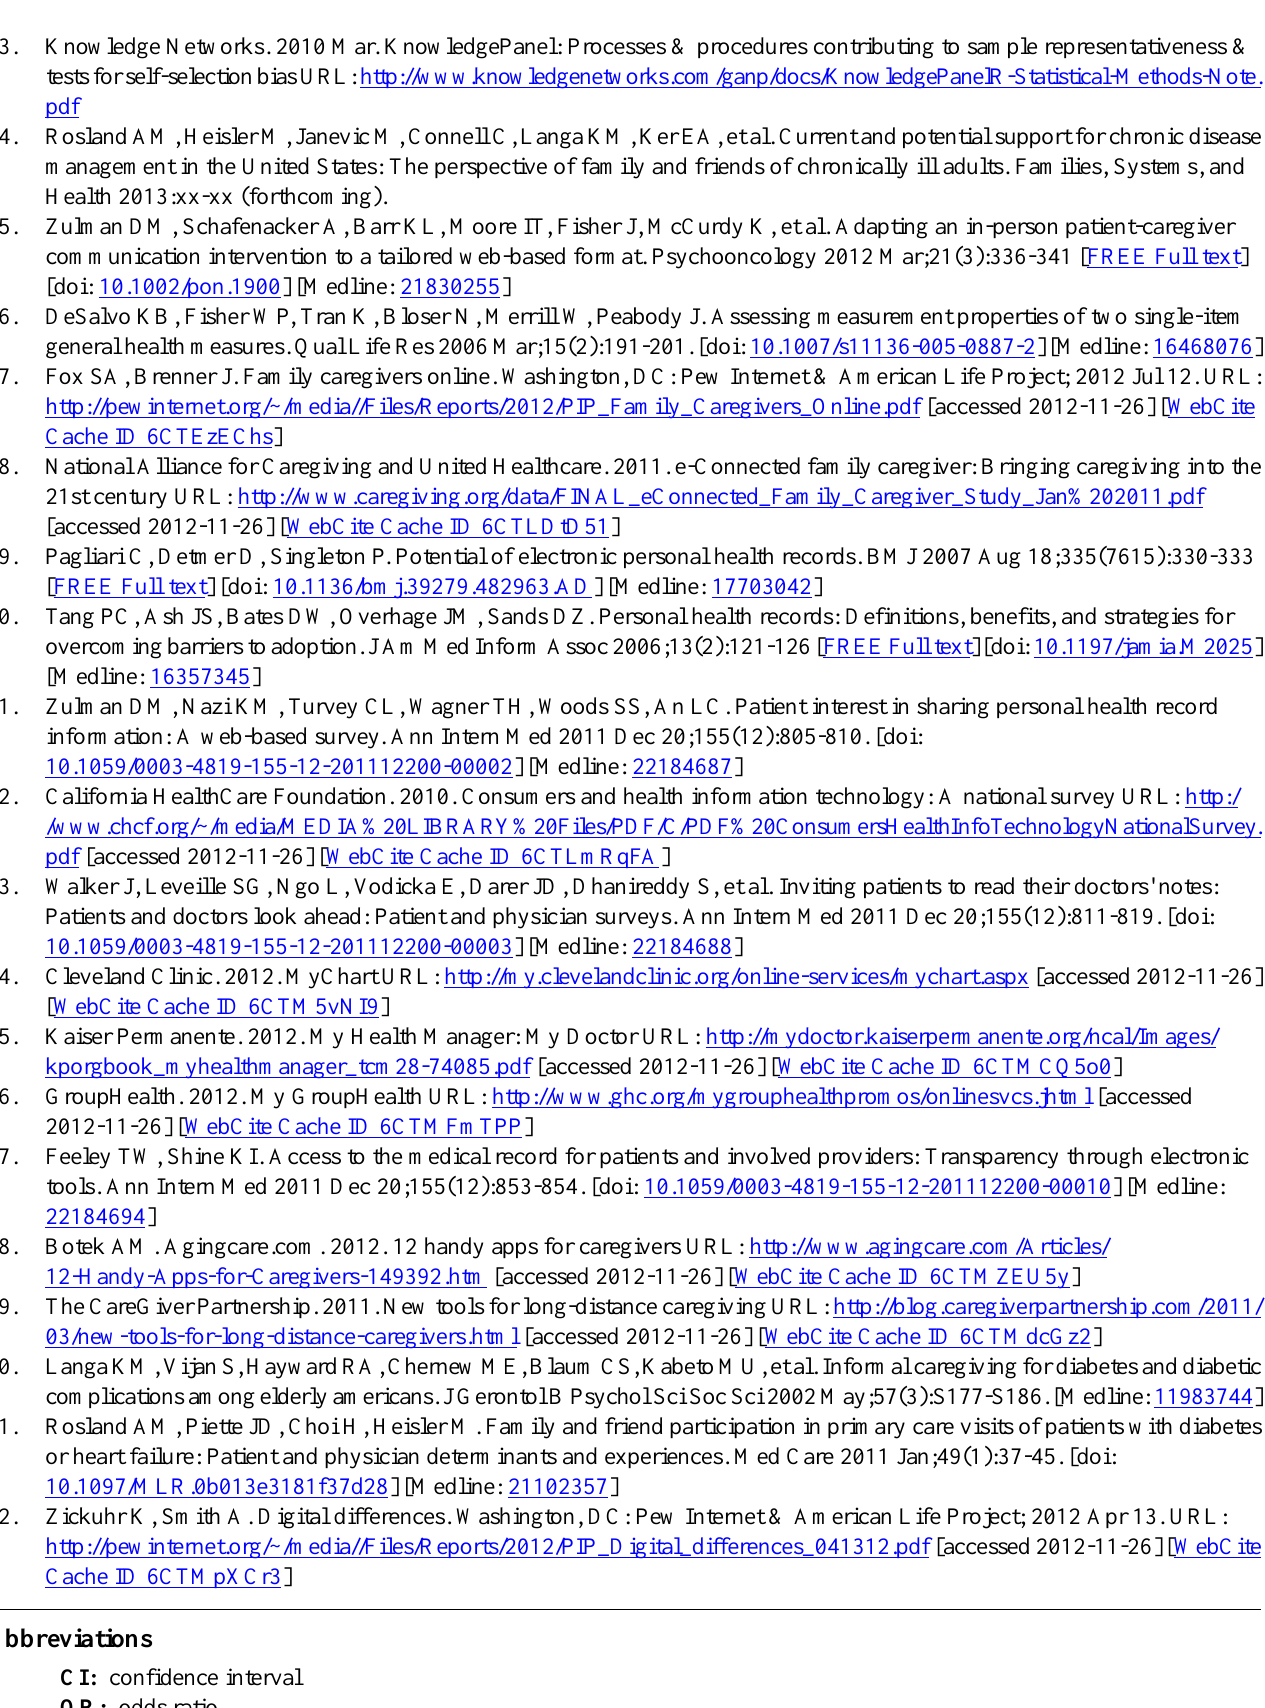
CI: confidence interval OR: odds ratio PHR: personal health